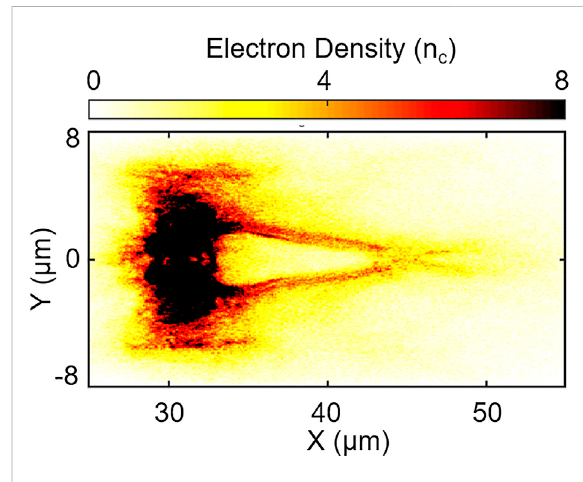
FIGURE 7 Longitudinal cross sections of electron density at t = 160 T L for topological charge of laser l =